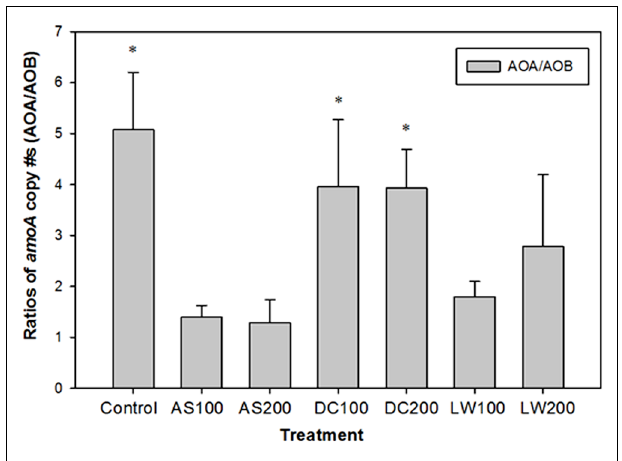
FIGURE 2 | Ratios of amoA copy # per gram of soil ofAOA toAOB. Soil treatments as in Figure 1 . *Bars with asterisk indicate that the copy # of amoA of AOA is significantly higher than the copy # of amoA of AOB for that treatment at p ≤